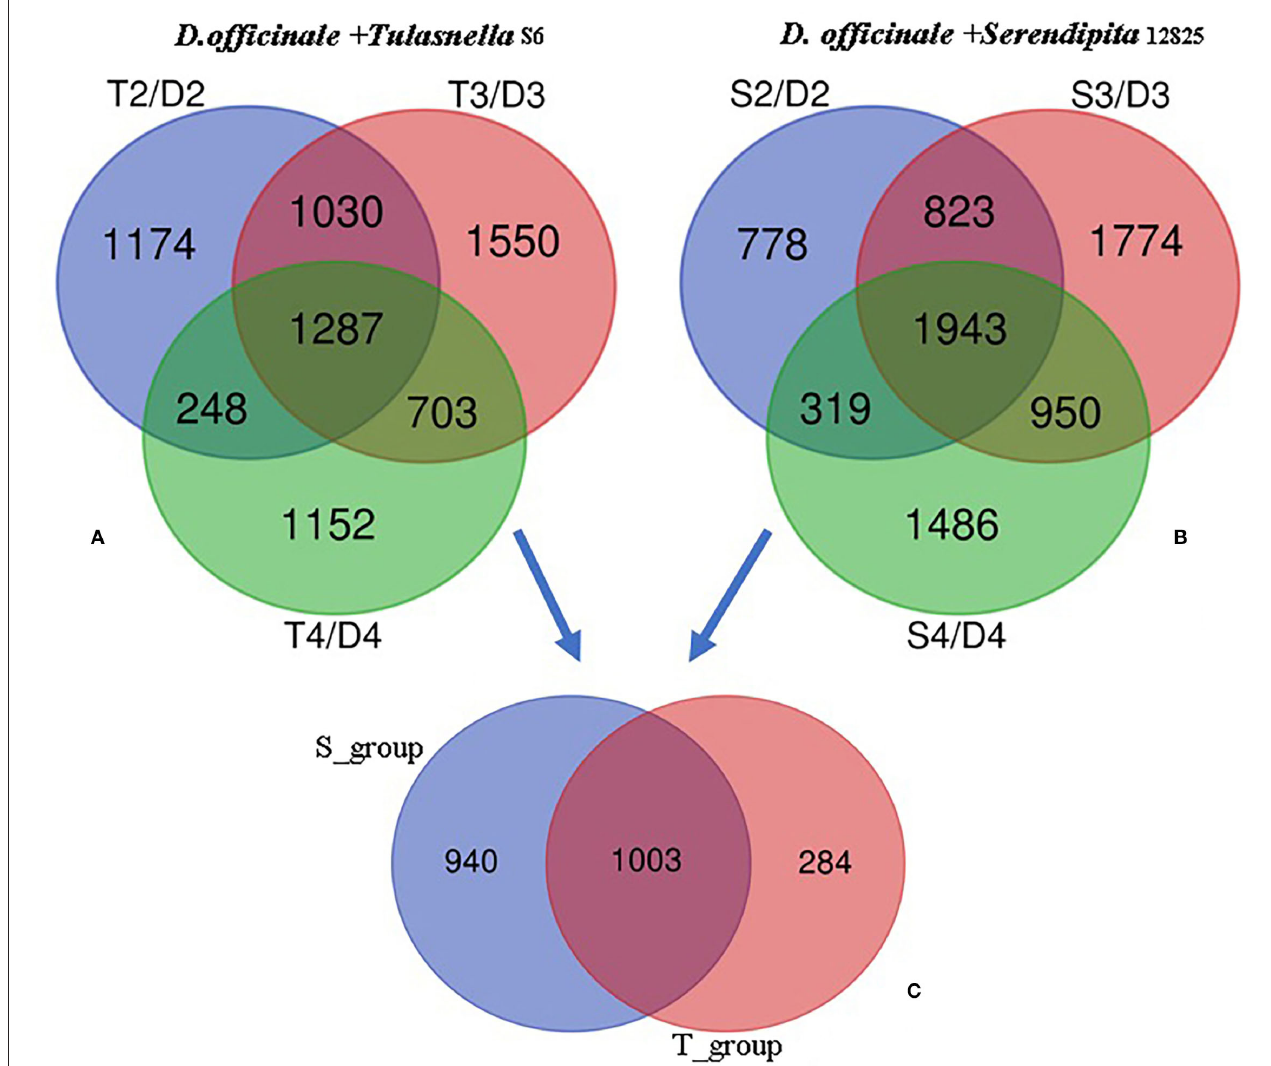
FIGURE 2 | Venn diagram showing the numbers of plant differentially expressed genes (DEGs) in the adjacent development stage of two symbiotic groups of D. officinale seeds with Tulasnella sp. (S6) and Serendipita sp. (12825), respectively. (A,B) DEGs at adjacent development stage during D.officinale seed with Tulasnella sp. (A) and Serendipita sp. (B) and compared to the same stage in asymbiotic germination; (C) 1,003 common differentially expressed plant genes across the three development stages (stages 2, 3, and 4) in symbiotic process with two different mycorrhizal fungi compared asymbiotic germination. D2, D3, and D4 mean